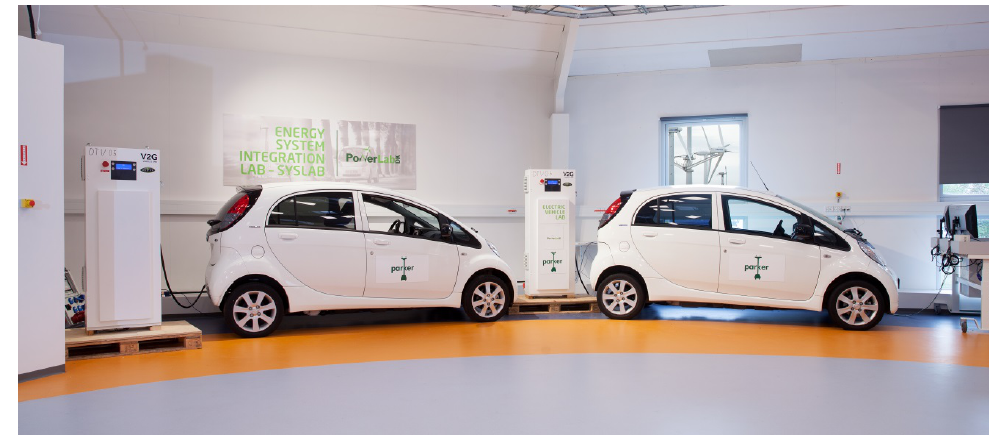
Figure 4. Parker laboratory